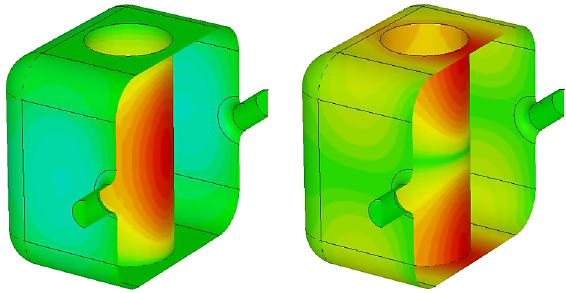
FIG. 10. Surface electric (left) and magnetic (right) fields in the parallel-bar design with cylindrical loading elements [Design